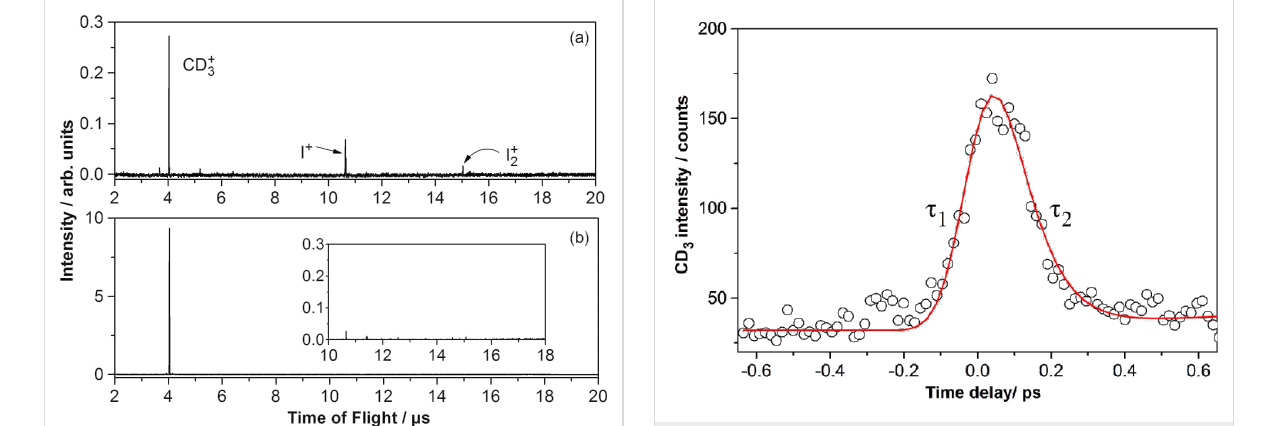
Figure 5: Femtosecond photodissociation reaction of multilayer methyl iodide adsorbed on 10 ML Au/Mo(100) recorded by monitoring the transient methyl cation signal intensity as a function of the pump–probe delay time (pump: 266 nm, 2 mW/cm² and probe: 333 nm 60 mW/cm²). The solid line is the best fit of an exponential “rise and decay” model to the experimental data, yielding the indicated time constants τ 1 and τ 2